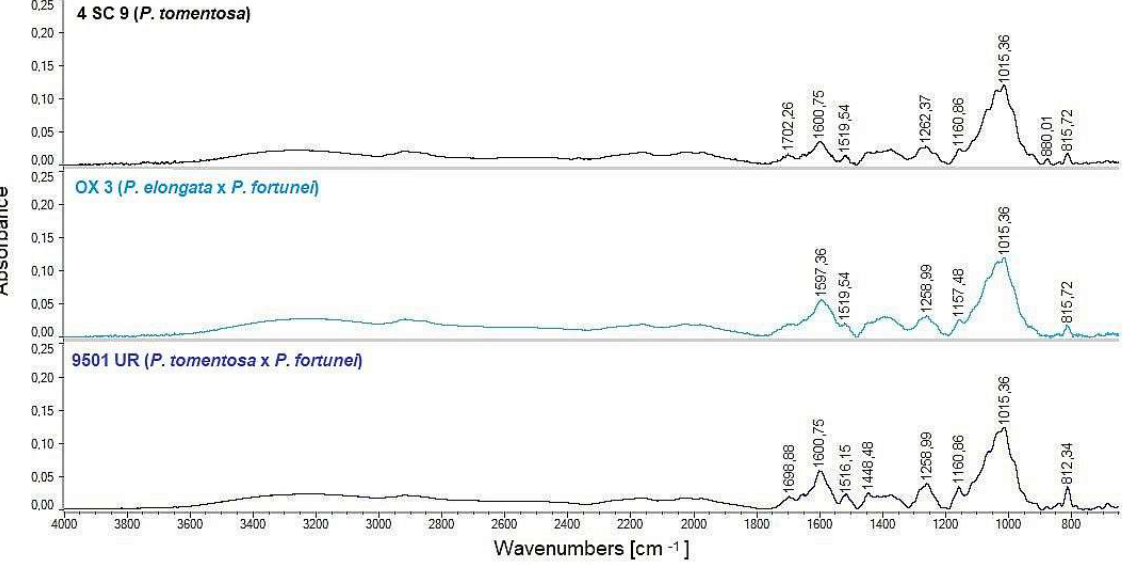
Figure 3. FT-IR spectra of dry extracts for selected representatives of individual